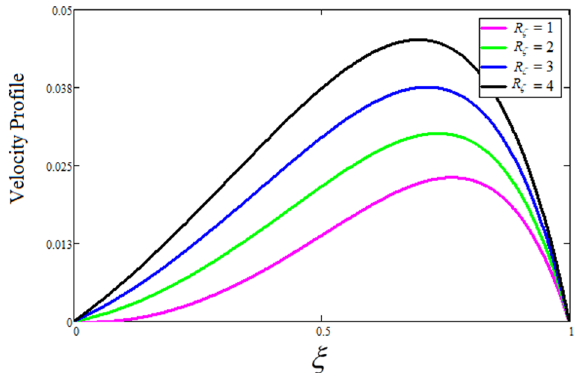
Figure 2. The consequence of R ζ on the velocity distribution. where φ = 0.04, δ = γ = π 3 , M = 5, k = 0.3, Gr = 10, Gm = 20, β = 0.2, α = 0.5, t = 1, Sc =